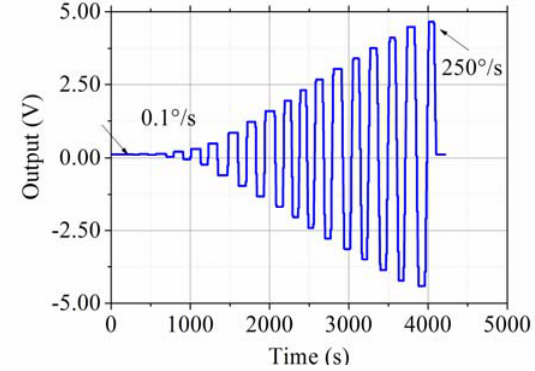
Figure 14. Output with different input angular rate with ±0.1 °/s, ±0.5 °/s, ±1 °/s, ±5 °/s, ±10 °/s, ±20 °/s, ±40 °/s, ±60 °/s, ±80 °/s, ±100 °/s, ±120 °/s, ±140 °/s, ±160 °/s, ±180 °/s,